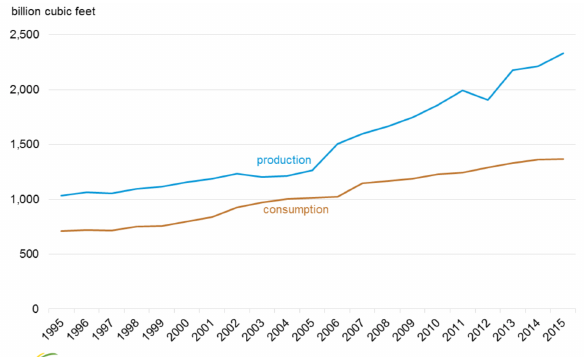
Figure 5. Australia’s natural gas production and consumption, 1995 to 2015